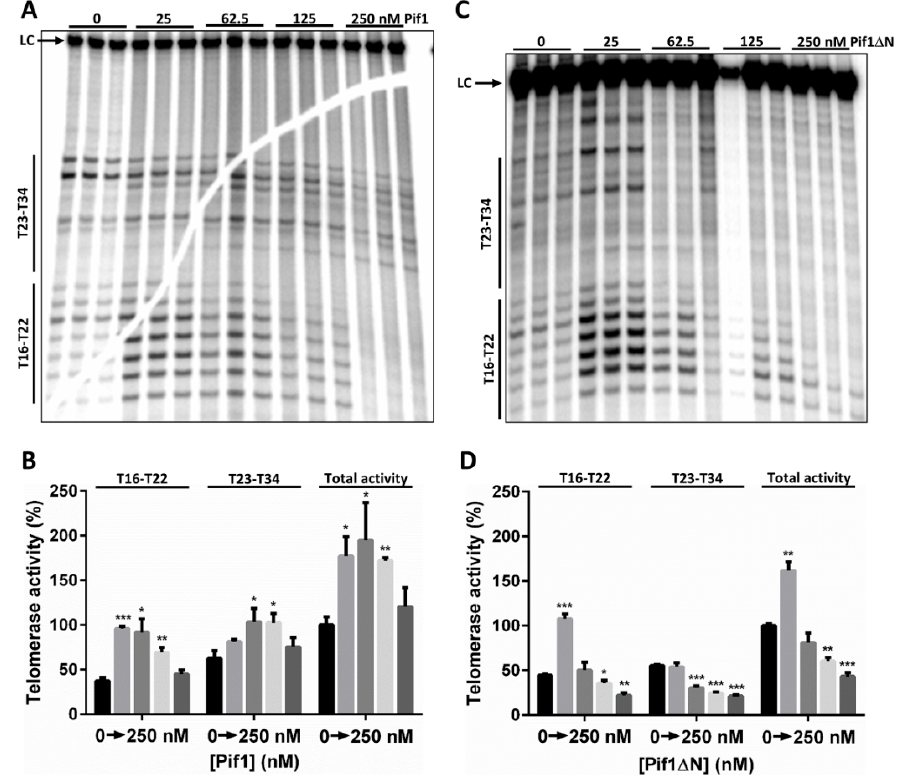
Figure 2. Pif1 Δ N is a potent in vitro telomerase inhibitor. ( A ) In vitro telomerase extension of